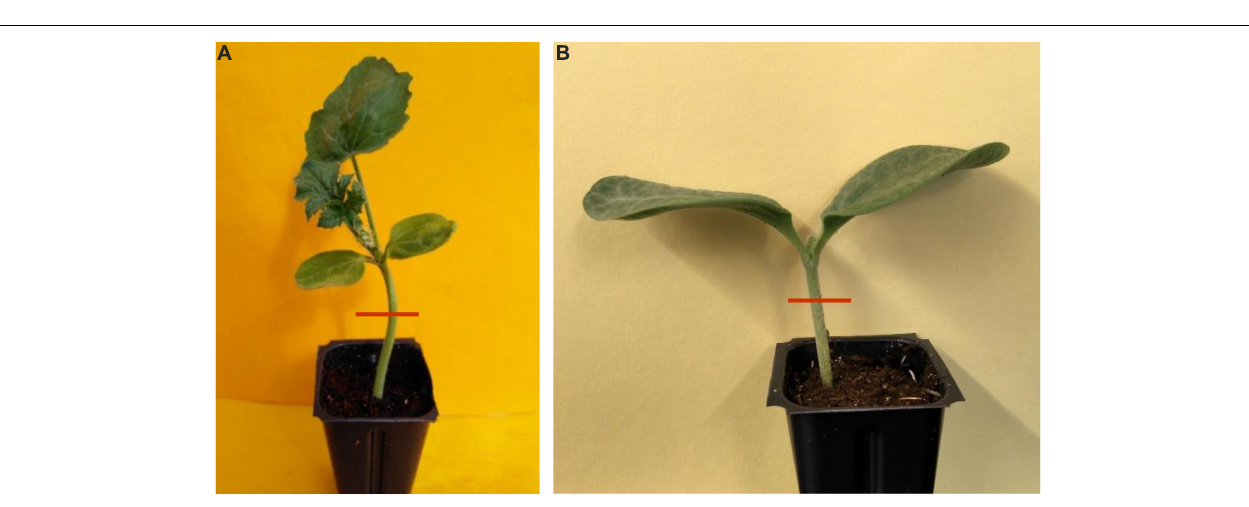
FIGURE 2 | Cross-section hypocotyl samples of non-grafted watermelon cultivar ‘Secretariat’ (A) and rootstock cultivar ‘Tetsukabuto’ (B) .